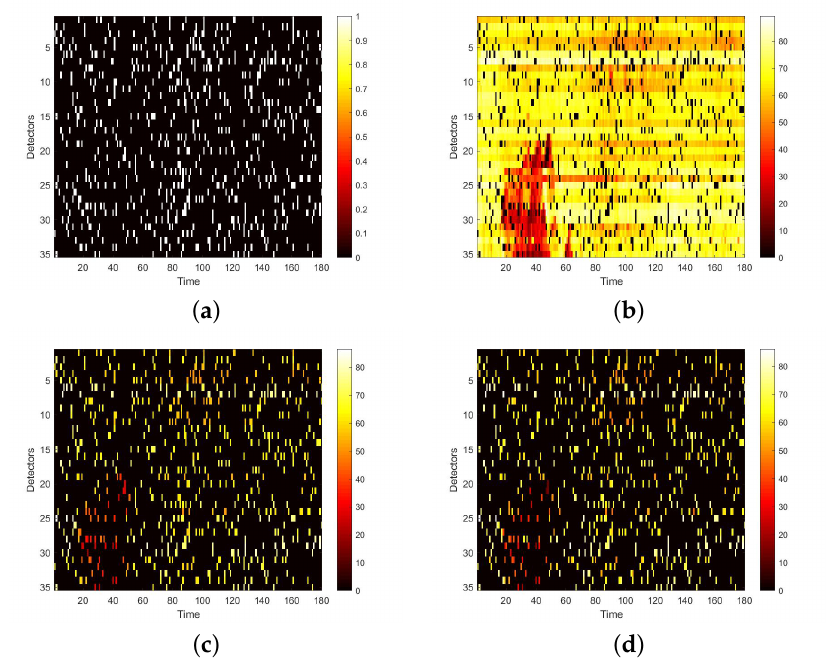
Figure 11. Speed matrices of Yan’an elevated highway (the 31st day of testset) with discrete damage visualized as heat maps. The ratio of damaged area to total area is 10%. ( a ) Mask matrix visualized as a heat map. ( b ) Damaged speed matrix visualized as a heat map. ( c ) Repaired speed matrix visualized as a heat map. ( d ) Real speed matrix visualized as a heat